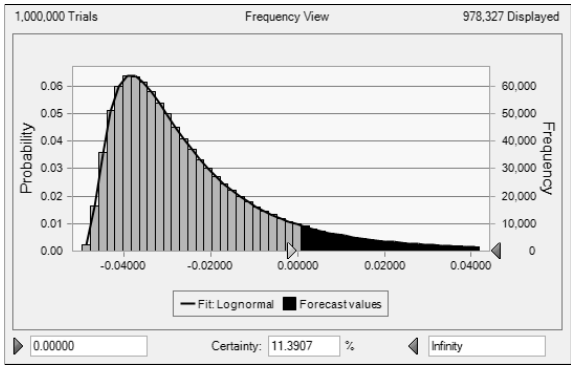
Figure 6. Simulated distribution of R for the MTS Case. Source: Own calculation applying Crystal